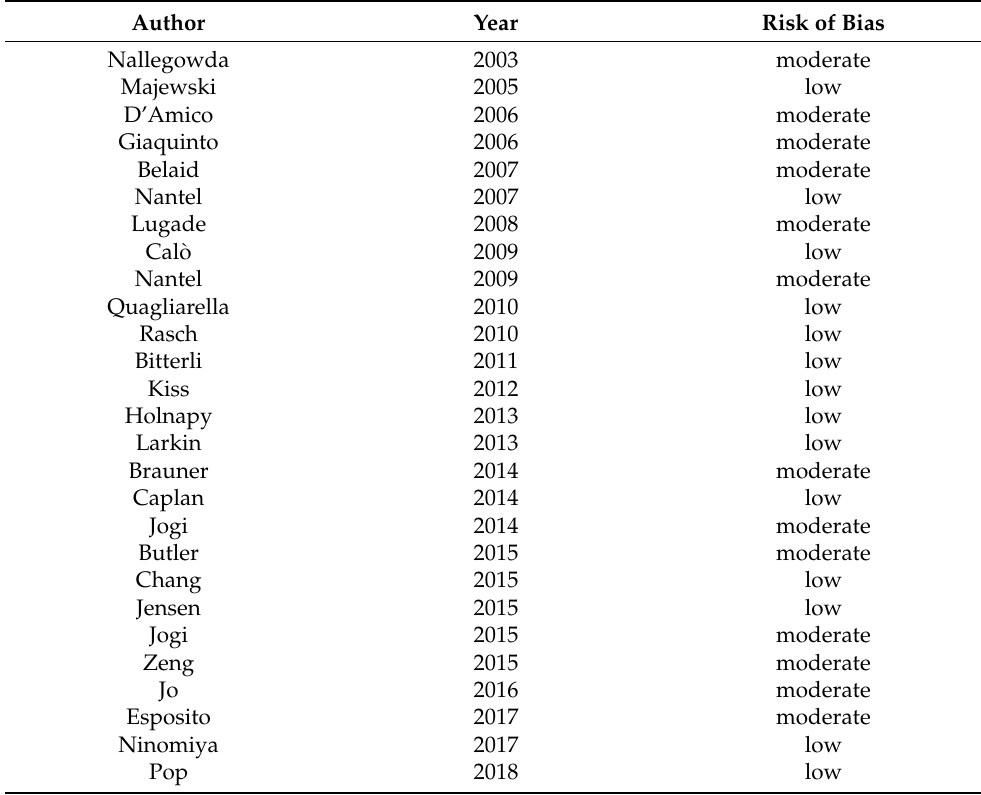
Table 2. Risk of Bias of the included